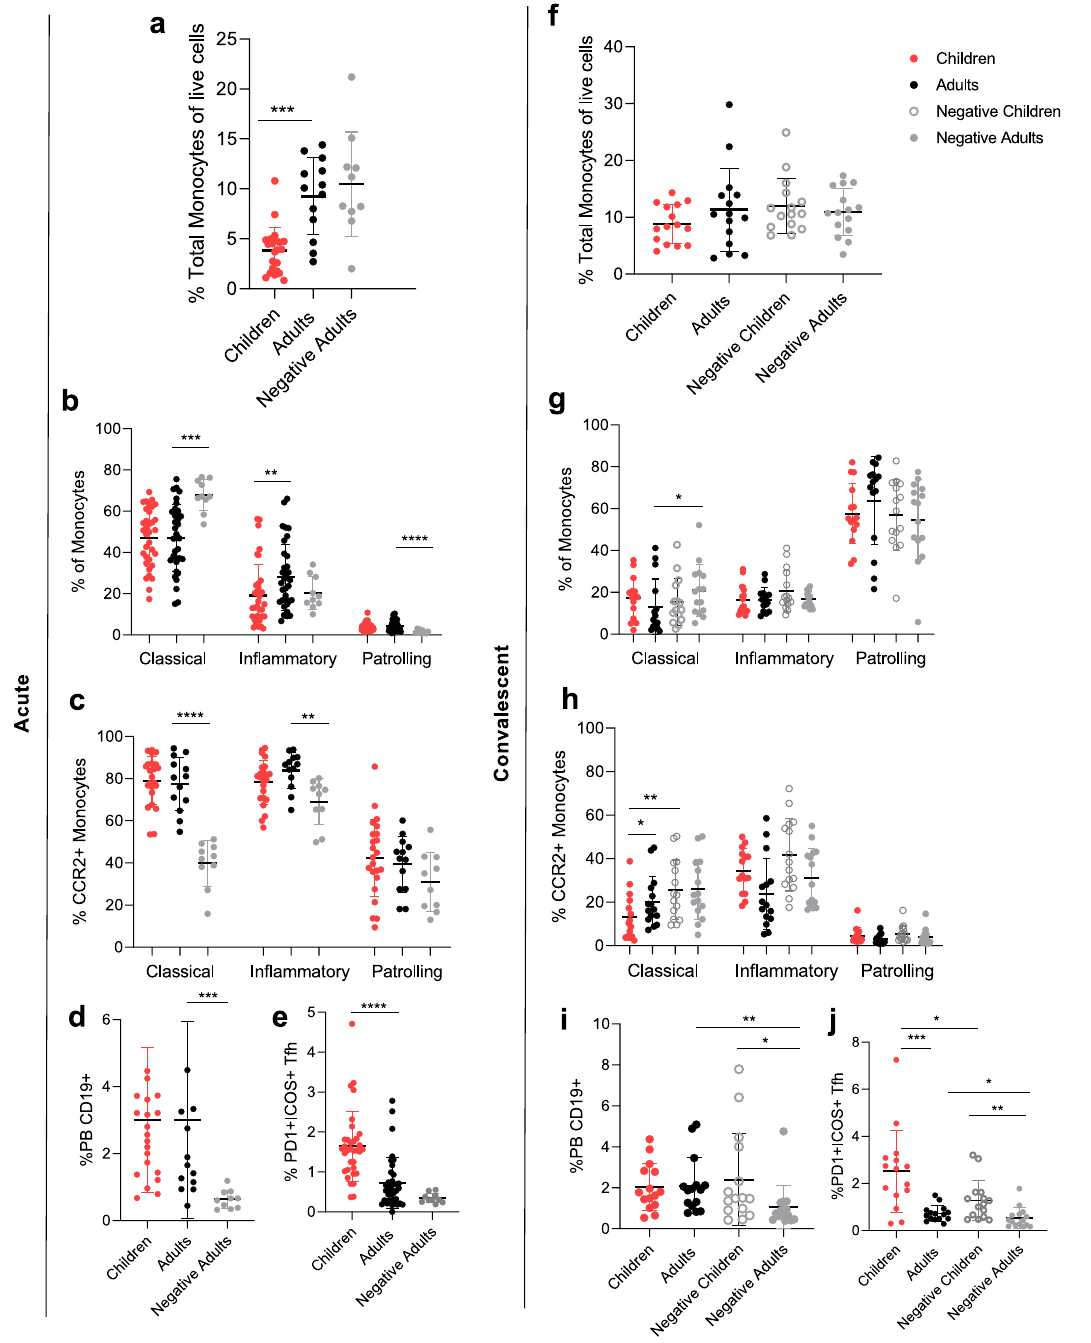
Fig. 4 Cellular recruitment of Tfh cell, plasmablasts, and monocytes. Early (<day 14) recruitment of innate and adaptive cells was measured by fl ow cytometry (see Supplementary Figure 3 for gating strategy) for COVID-19 children ( n = 22), adults ( n = 13), and negative controls ( n = 10) ( a – e ). Convalescent/ memory samples of children ( n = 15), adults ( n = 15), and negative adults ( n = 15) were also tested alongside negative children ( n = 15) ( f – j ). Total monocytes ( a , f ), monocyte phenotype ( b , g ), and activation of monocytes ( c , h ). Total plasmablast ( d , i ) and activated T follicular helper cell ( e , f ). Data represents the individual response, mean±SD. Statistical differences were determined using a two-sided Mann – Whitney test between children and adults, adults and negative adults, and children and negative children where ** p <0.01, *** p <0.001, **** p <0.0001. a *** p = 0.0002, ( b ) ** p = 0.0054, *** p = 0.0001, **** p <0.0001, ( c ) ** p = 0.0020, **** p <0.0001, ( d ) *** p = 0.0001, ( e ) **** p <0.0001, ( g ) * p = 0.0321, ( h ) * p = 0.0203, ** p = 0.0086, ( i ) * p = 0.0124, ** p = 0.0016, ( j ) * p = 0.0489, 0.0235, ** p = 0.0013, *** p = Prior common cold coronavirus immunity and cellular structure-speci fi c T cells at memory time points (Fig. 6d), responses . The level of coronavirus Spike-speci fi c IgG was however showed that children had reduced T effector memory determined at early time points (< 14 days) of SARS-CoV-2 (TEM) CD4 + T cells compared to infected adults (Fig. 6e). The infection, to determine if pre-existing immunity impacted T cell phenotype of structure-speci fi c CD8 + T cells was comparable (Fig. 6f). responses. The magnitude of α -coronavirus 229E and NL63-